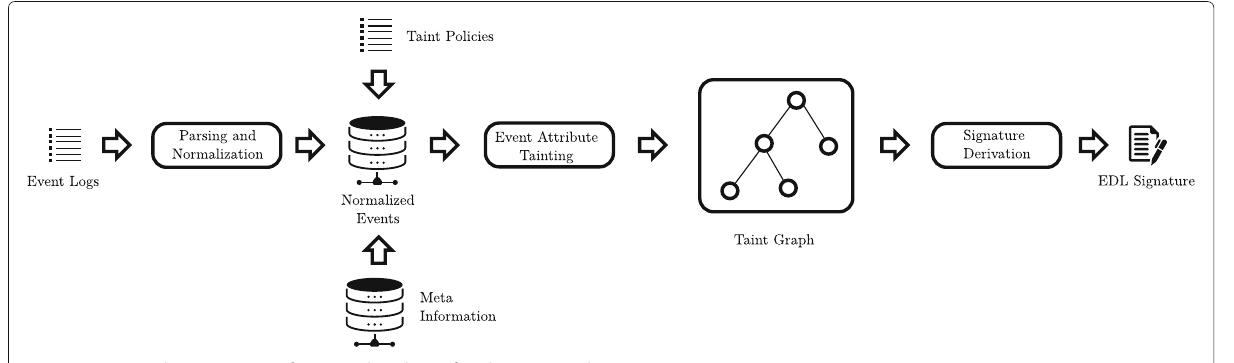
Fig. 9 Signature derivation steps for tainted analysis of multi-step attacks [61]